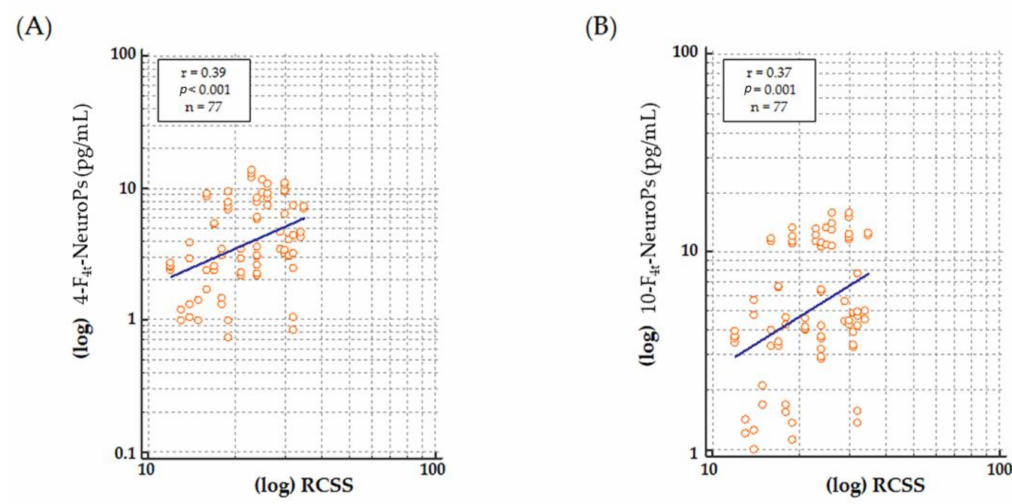
Figure 5. Scatterplot and linear regression of plasma 4-F 4t- NeuroP ( A ) and 10-F 4t -NeuroP ( B ) against. RTT clinical severity (RCSS). In each panel, correlation coefficient (r), p value ( p ), and number of patients (n) are displayed.